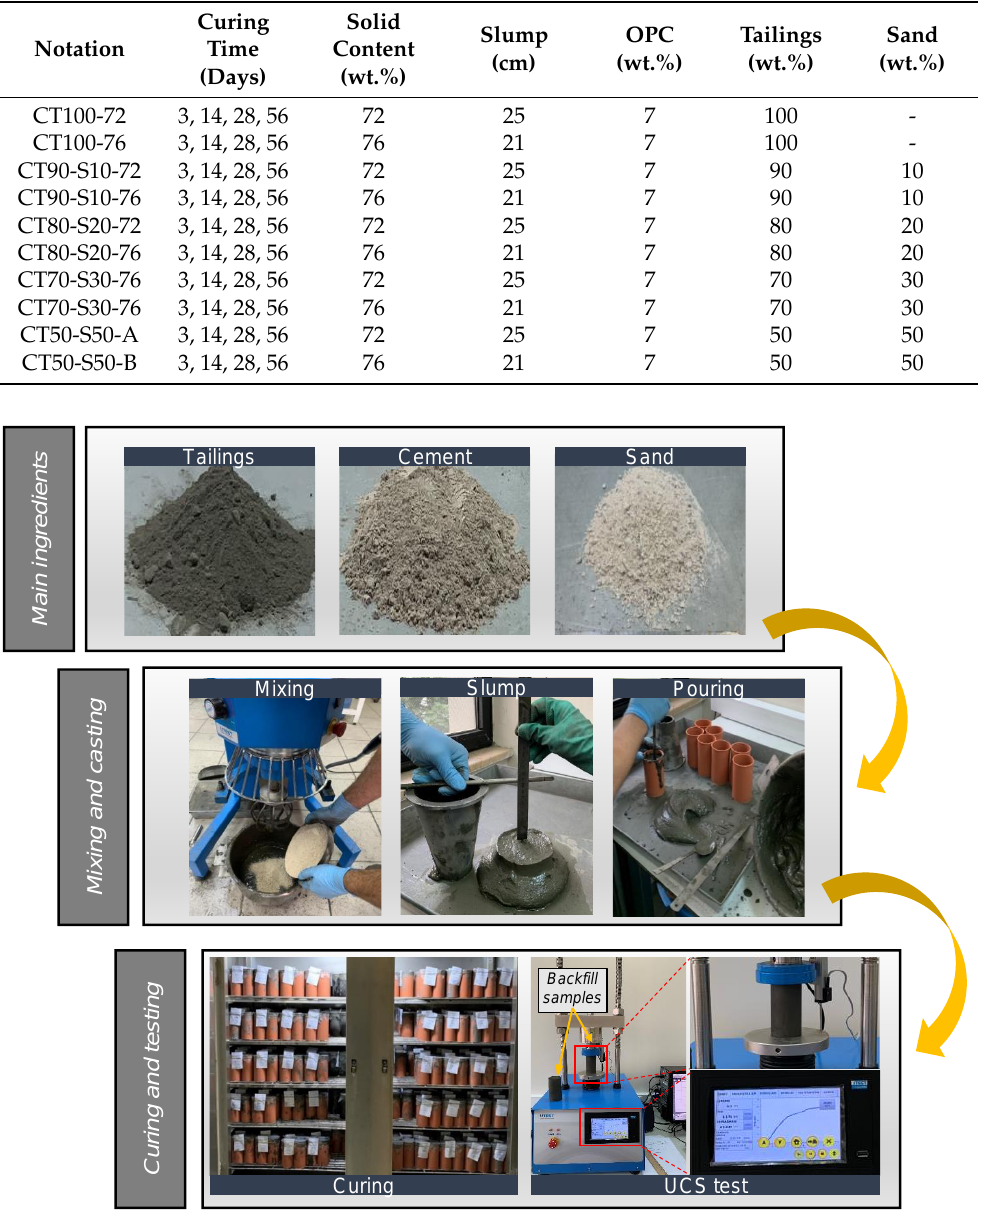
Figure 2. Specimen preparation steps.